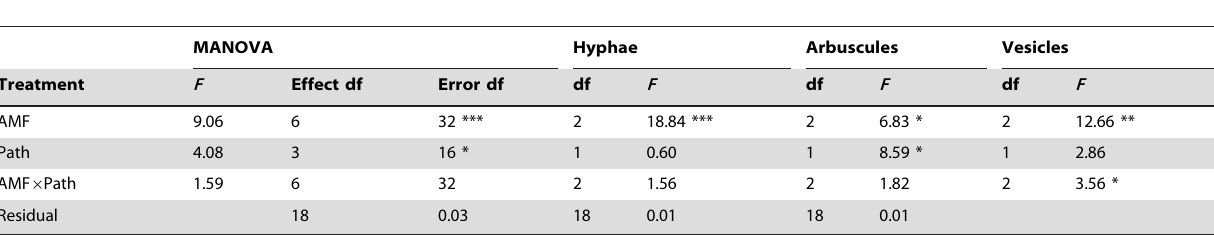
Table 2. (M)ANOVA of percent root length colonized by each AMF